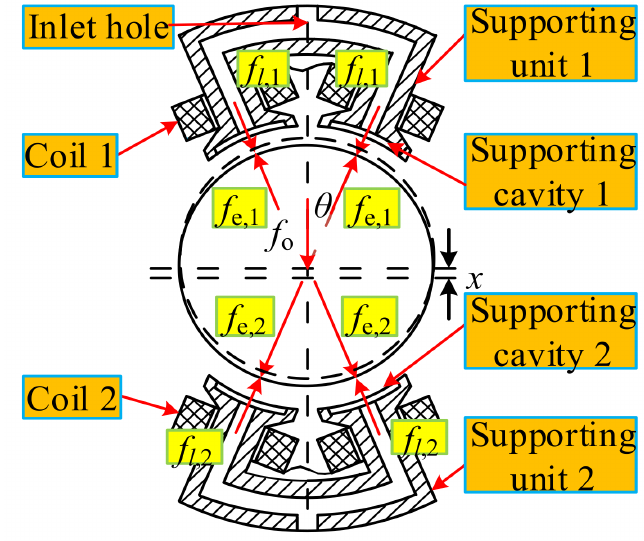
Figure 5. Force diagram of single DOF